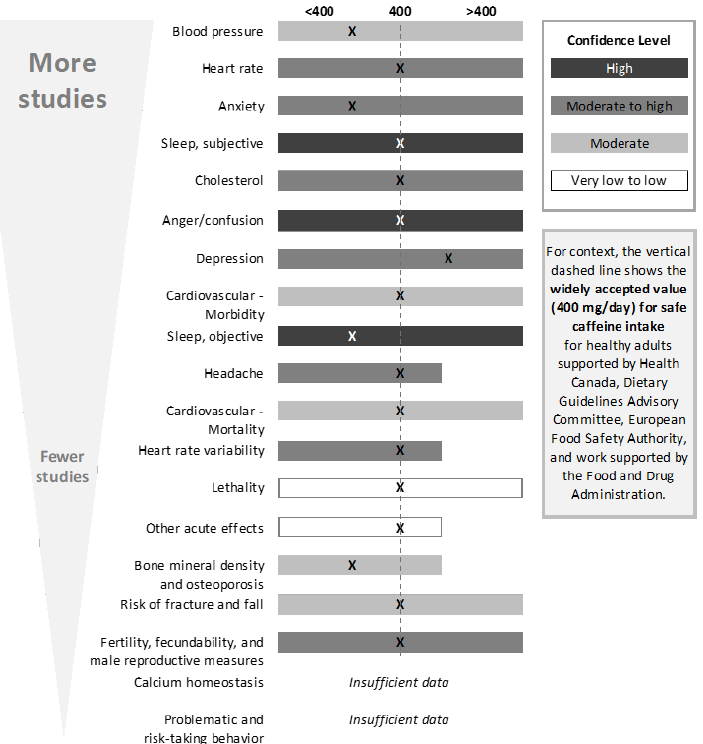
Figure 5. Summary of the spectrum of data and our endpoint conclusions for healthy adults, weighted for level of confidence in the body of evidence considering risk of bias, magnitude, consistency, and other factors. Shading indicates that data reported effects at the corresponding intake level (<400, 400, or >400 mg caffeine/day), and darker shading indicates increased confidence in the body of evidence (from very low to high). X indicates the SR weight-of-evidence conclusion for the level of intake not associated with significant health effects. Although effects were observed at exposures below 400 mg (e.g., blood pressure, bone mineral density and osteoporosis), these results did not affect the overall conclusion of the SR, due to considerable variability in individuals’ sensitivity to caffeine and potential confounding, and the effects were limited to physiological effects following acute exposure, and subgroups of clinical endpoints, such as those with low calcium intake. Such effects were generally of low magnitude, and/or were of overall low or negligible consequence to downstream effects. Several studies also showed a lack of effects on clinical endpoints at exposures above 400